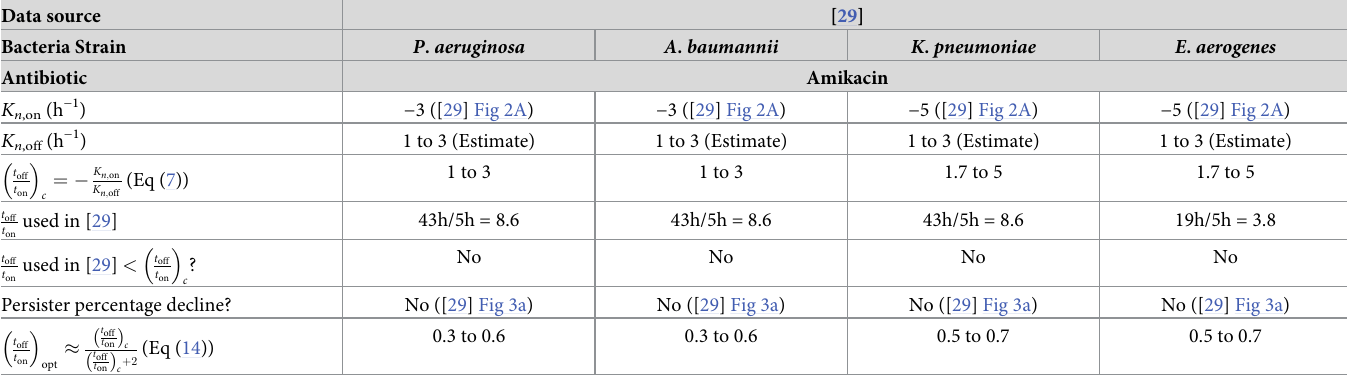
Table 3. Literature data analysis to test proposed theory for pulse dosing regimen